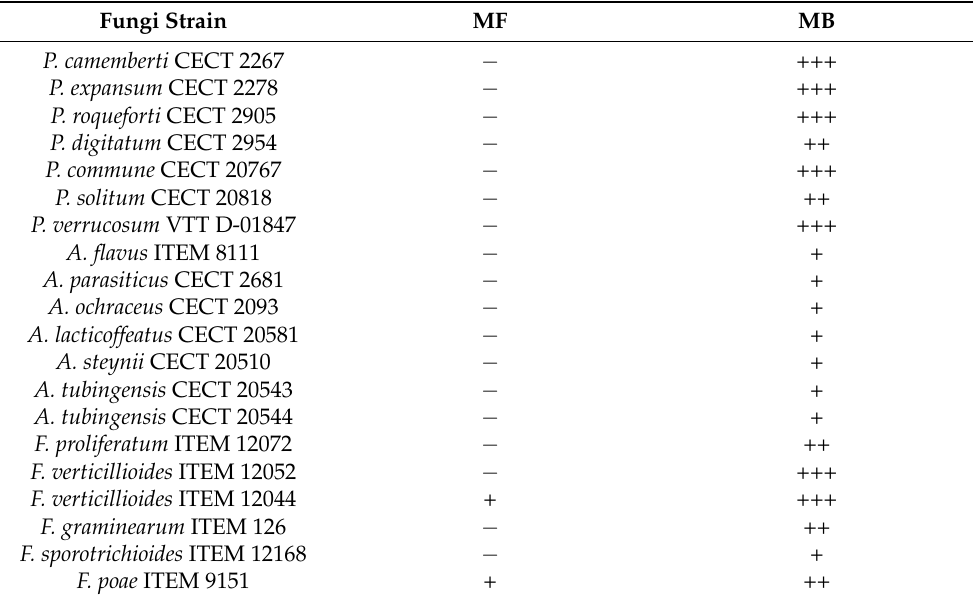
Table 1. Antifungal activity of white mustard seed flour (MF) and white mustard bran (MB) extracts in agar diffusion method against Penicillium , Aspergillus , and Fusarium spp. Fungi Strain